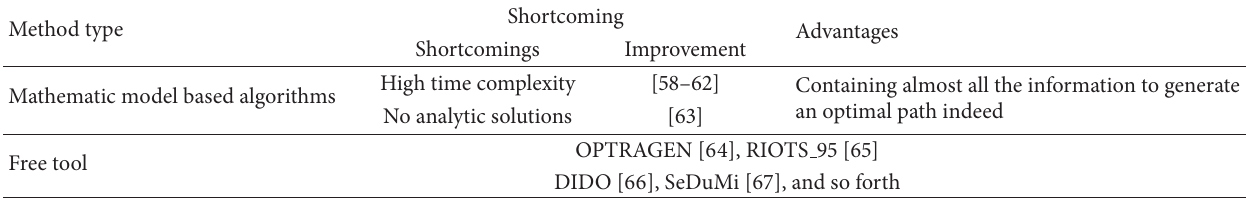
Table 4: Analysis of mathematic model based